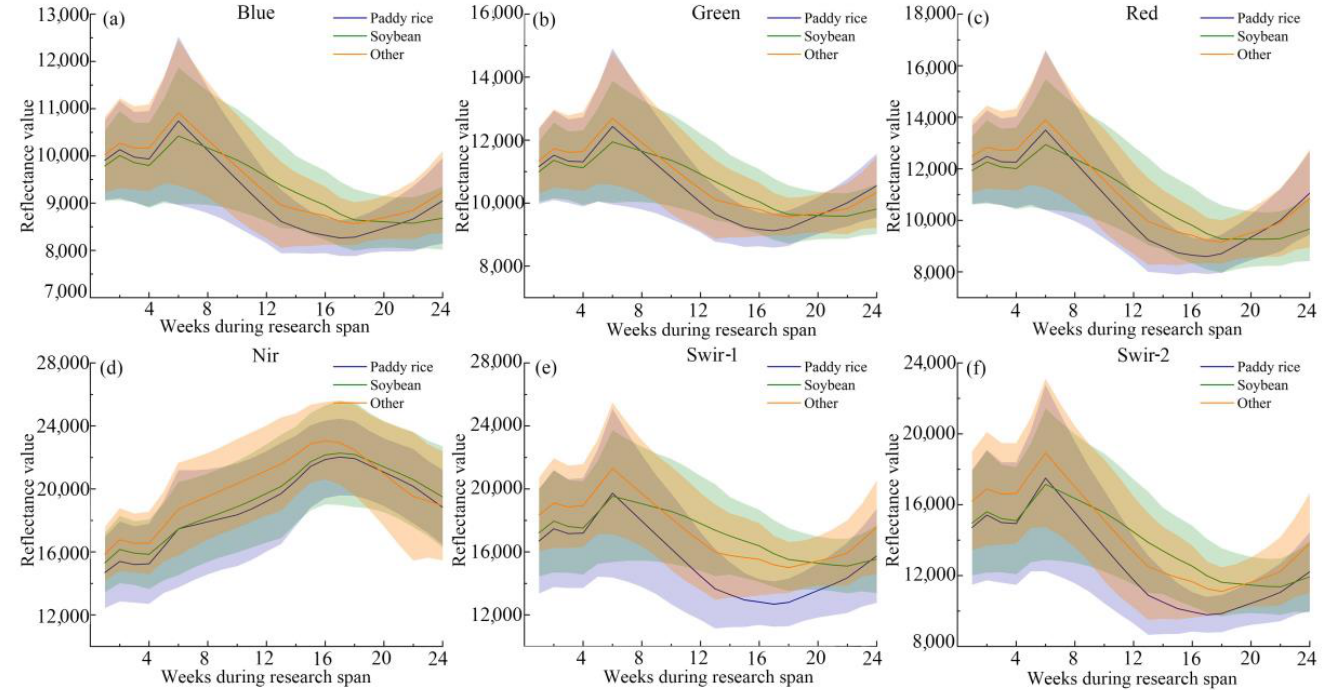
Figure 5. Seasonal profiles of spectral reflectance of paddy rice, soybean, and “other” pixels from 2017 to 2019. The buffers indicate one standard deviation calculated from all fields and years. The X-axis represents research span (a total of 24 weeks) and the Y-axis is the value of reflectance. The blue lines represent the average values of paddy rice, the green lines represent the average values of soybeans, and the orange lines represent the average values of “other”. ( a ) Blue band. ( b ) Green band. ( c ) Red band. ( d ) Nir band. ( e ) Swir-1 band. ( f ) Swir-2 band.